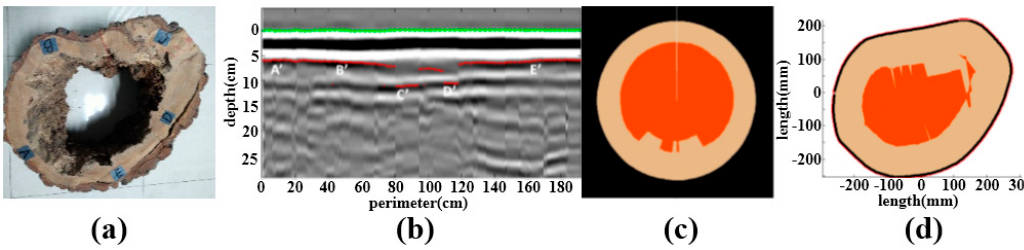
Figure 9. ( a ) Samples of T1; ( b ) B-scan data with the defect region boundary expressed in the red line